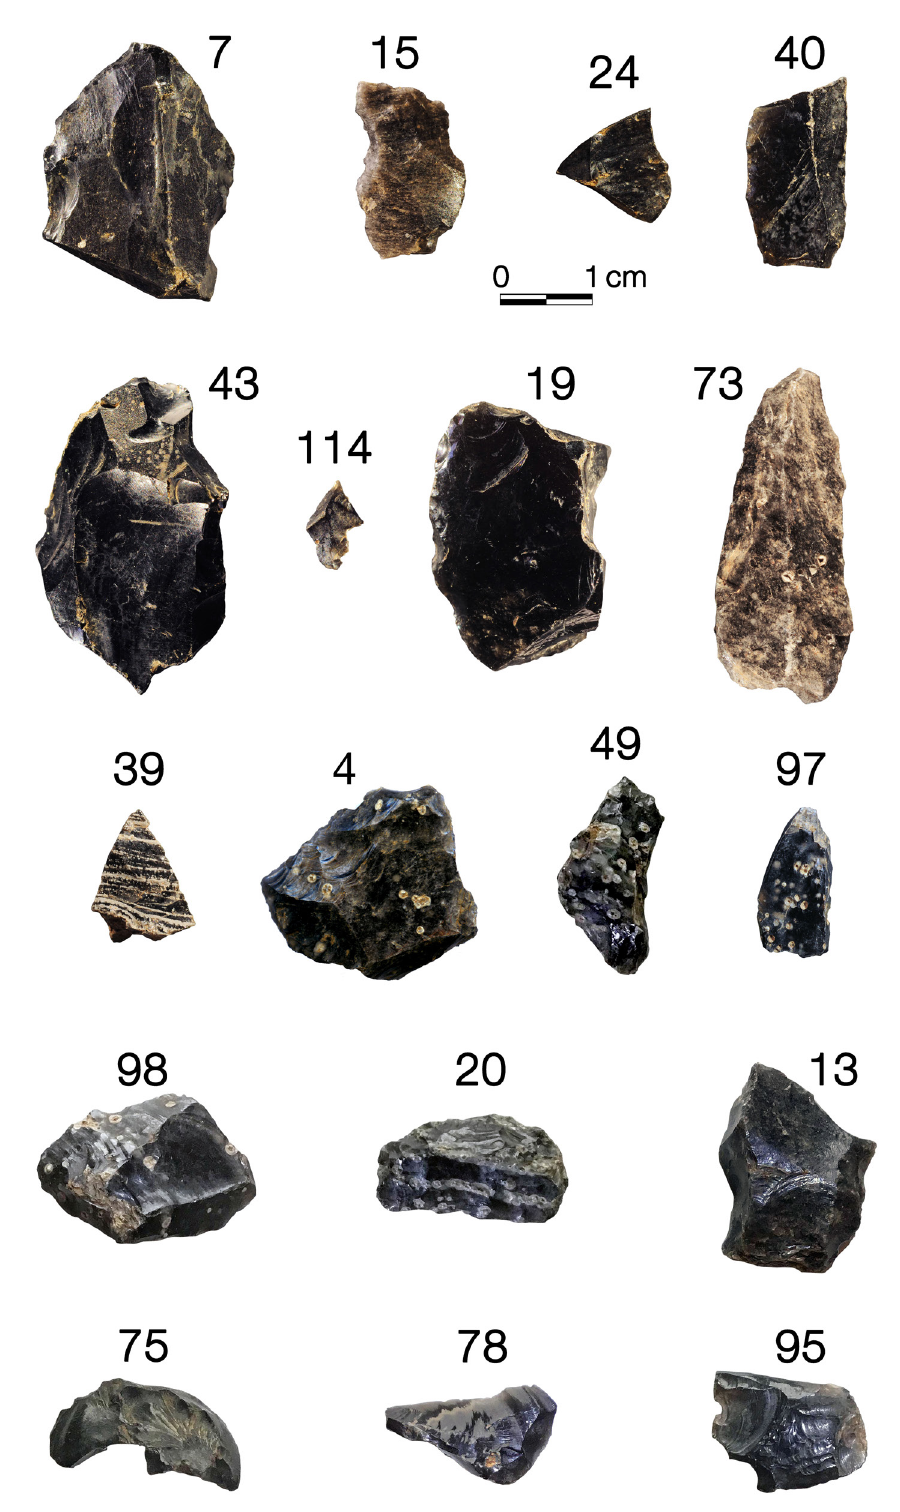
Figure 4: Some selected fragments of the Casa dei Francesi obsidian assemblage. In the first row, the only 4 obsidian samples recognised as man-made tools; in the following rows some representative samples of the debitages with particular texture or relevant typological characteristics. The numbers indicate the USFRA specimen, as described in the